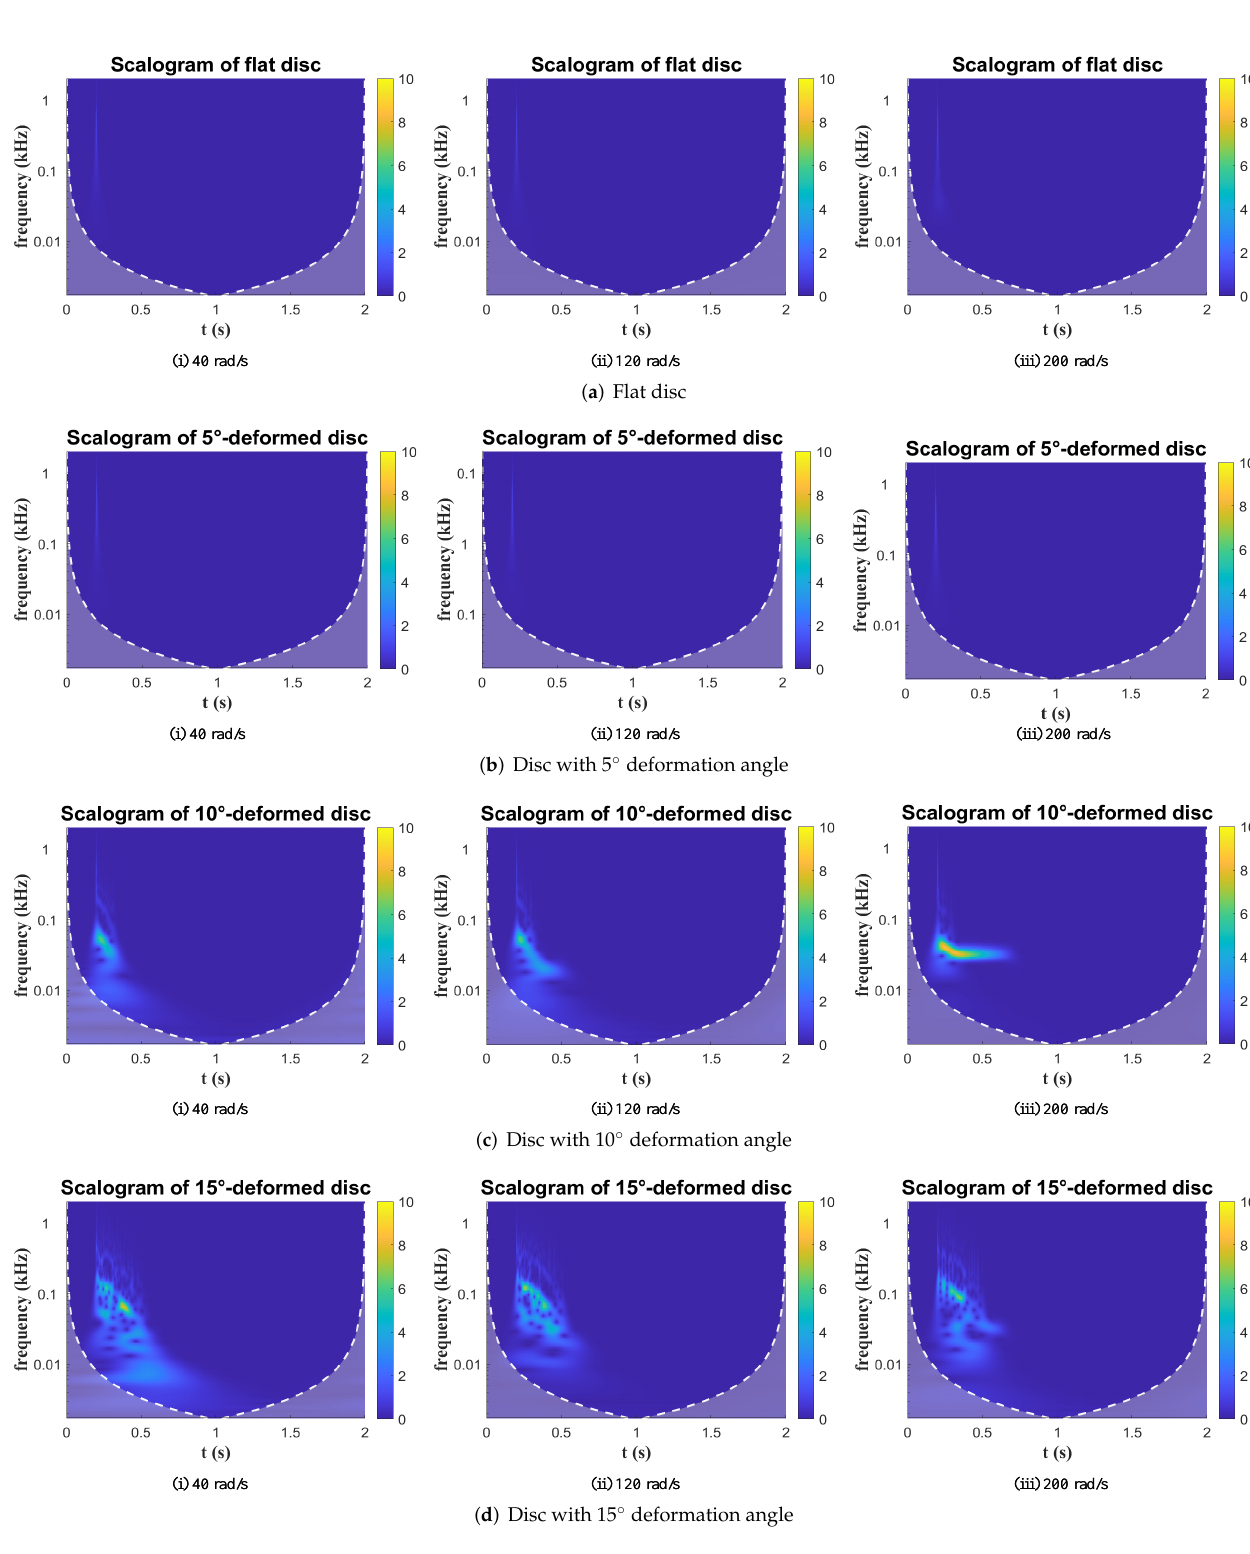
Figure 12. Scalogram: BC = 7 mm, initial force = 5